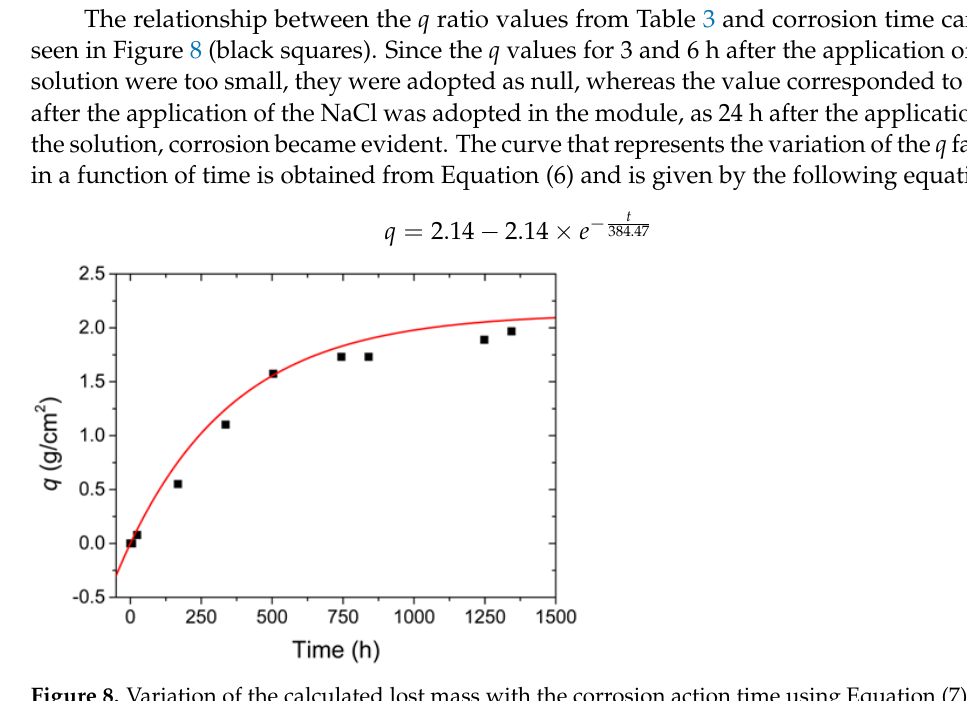
Table 3. Determination of the q factor, the ratio between the calculated lost mass and the area of the application region of the corrosive solution.